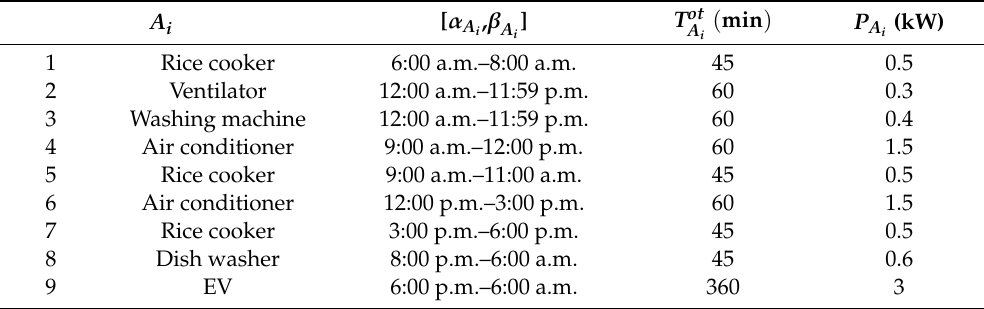
Table 1. Controllable load (CL) properties. EV – electric vehicle.